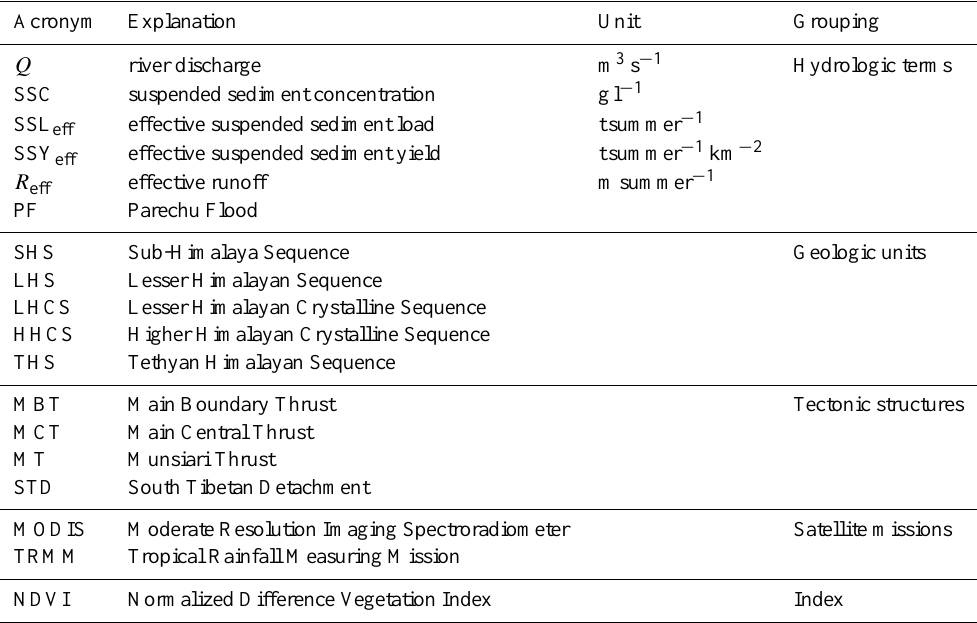
Table 1. Explanation of acronyms and abbreviations used in this study. SSL eff , SSY eff , and R eff refer to the summer half-year (May to